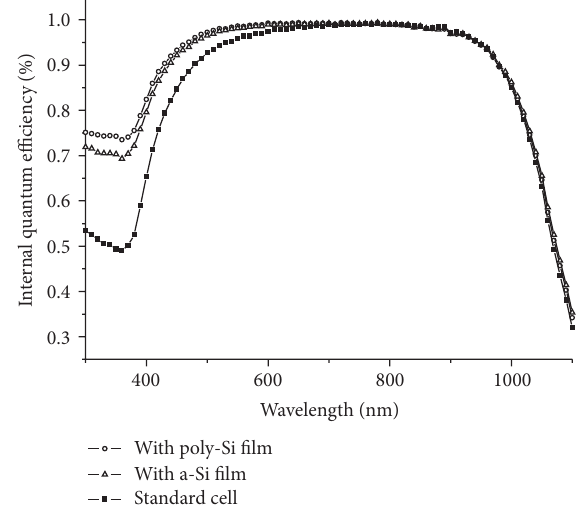
Figure 7: Internal quantum efficiency for a standard solar cell (- ◼ -), a solar cell with ∼ 4 nm poly-silicon film (- I -), and a solar cell with ∼ 5 nm amorphous-silicon film (- Δ